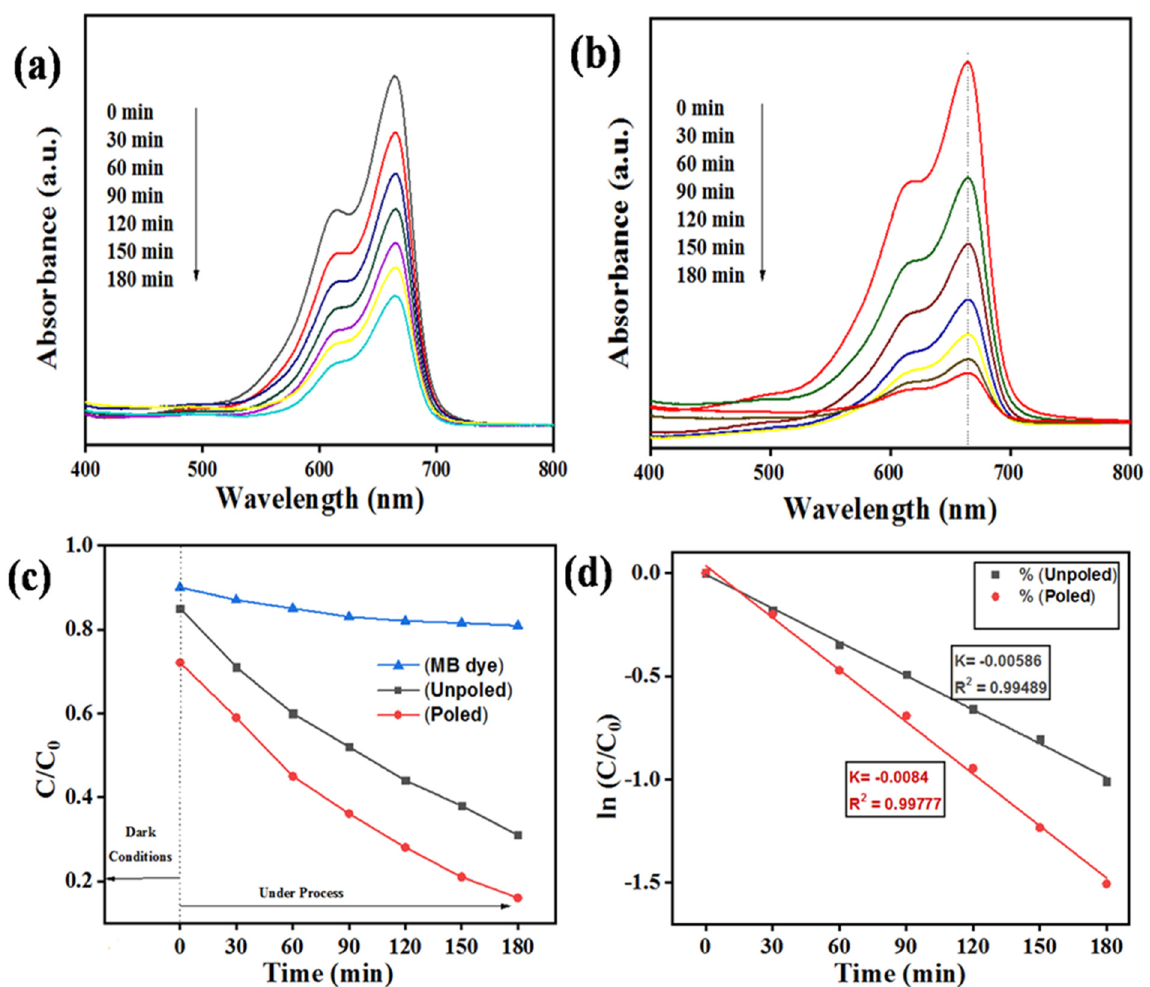
Figure 7. ( a ) Absorbance spectra of MB dye through photocatalysis process under visible light using 0.1 g of unpoled BST ‒ BZT composition, ( b ) absorbance spectra of MB dye through photocatalysis process under visible light using 0.1 g of poled BST ‒ BZT composition, ( c )% degradation of MB dye after 3 h using 0.1 g of unpoled and poled BST ‒ BZT powder through photocatalysis process, and ( d ) kinetic parameter of MB dye using 0.1 g of unpoled and poled BST ‒ BZT powder under visible light. The degradation of MB dye was measured by following Equation (2)